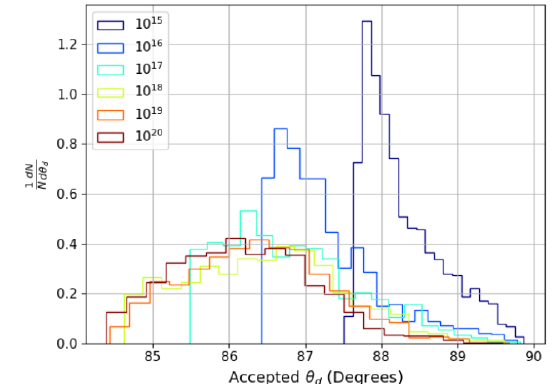
Figure 8: Normalized distributions of (arrival) zenith an- gles of accepted above-the-limb cosmic rays for various primary cosmic ray energies. For the 33 km altitude of EUSO-SPB2, Earth’s limb appears at 84 . 18 ◦ .